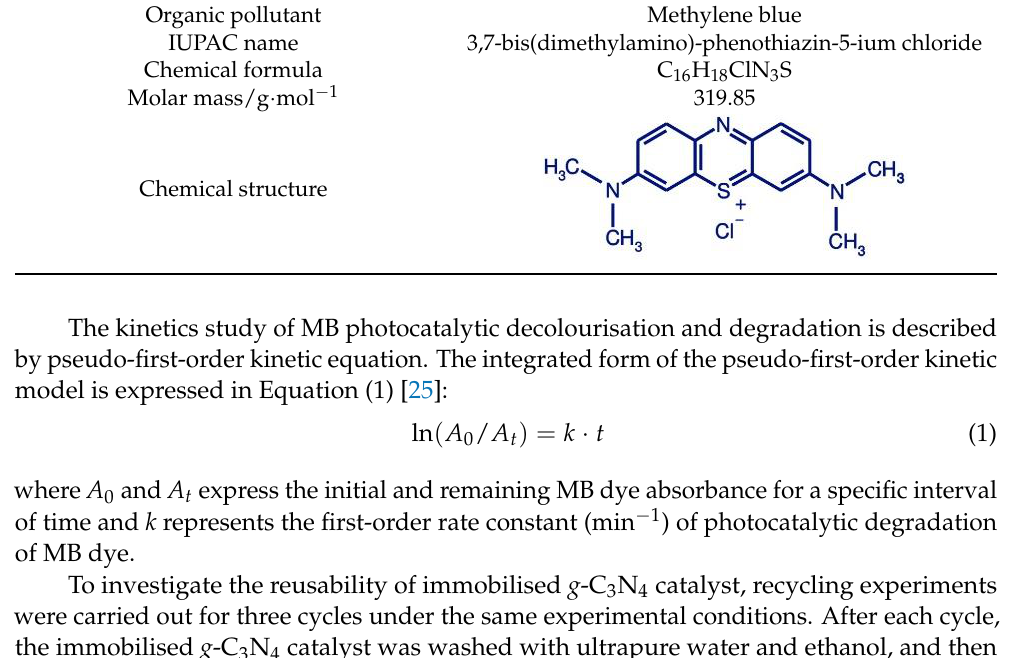
Table 2. Physico-chemical properties of the understudied organic pollutant MB dye. Organic pollutant